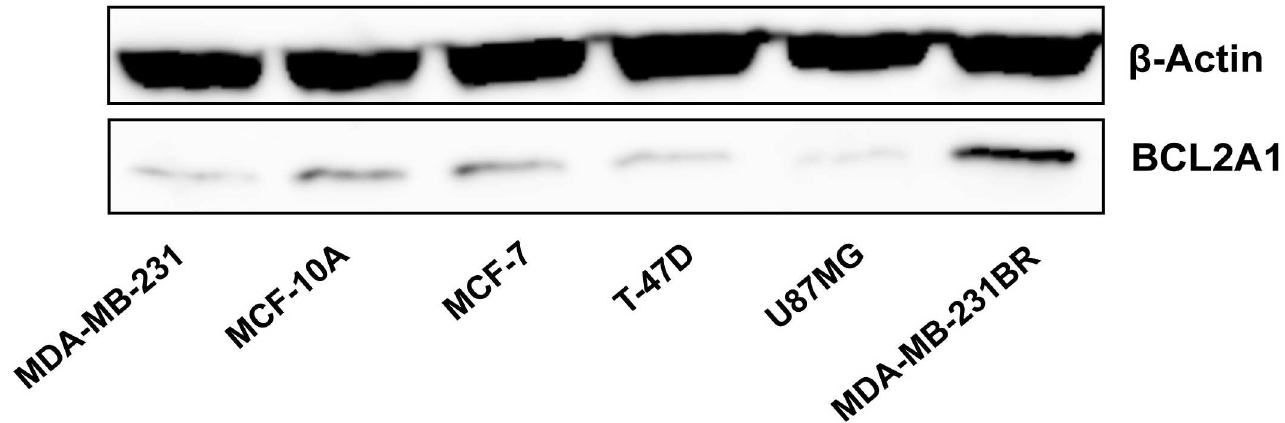
Fig 9. Protein expression of BCL2A1 in various human cell